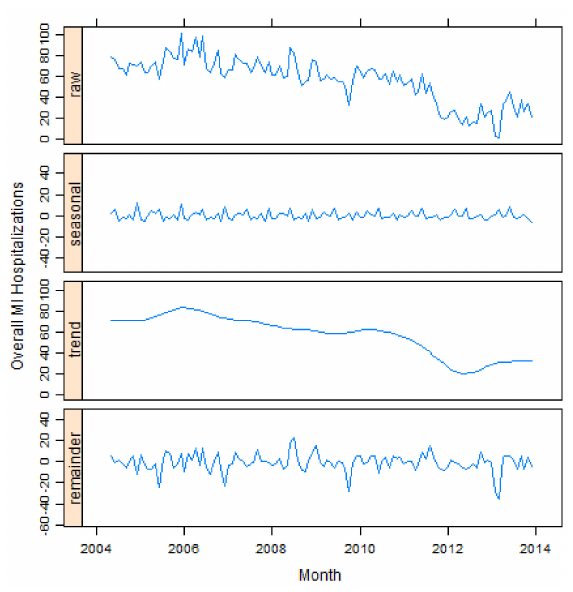
Figure 3. Seasonal trend decomposition plots for overall MI groups.